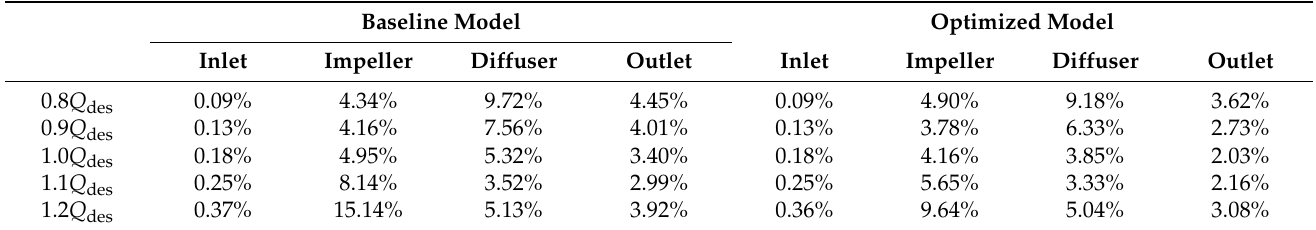
Table 5. Analysis of hydraulic loss.